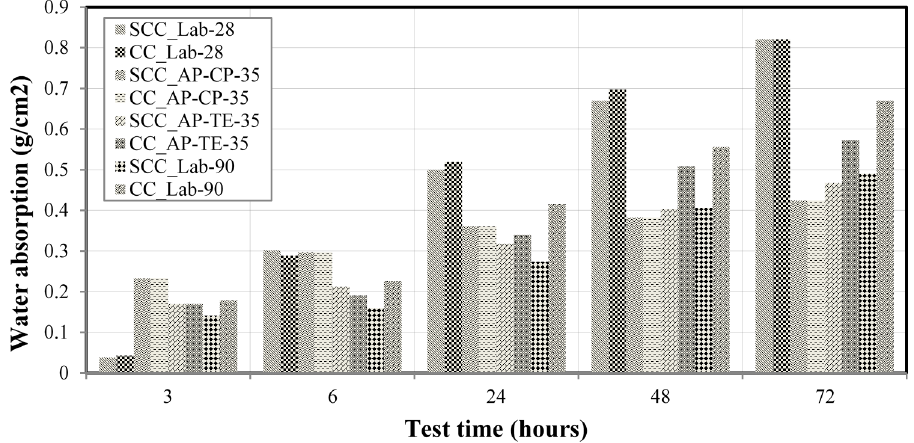
Figure 11. Results of capillarity water absorption in the performed